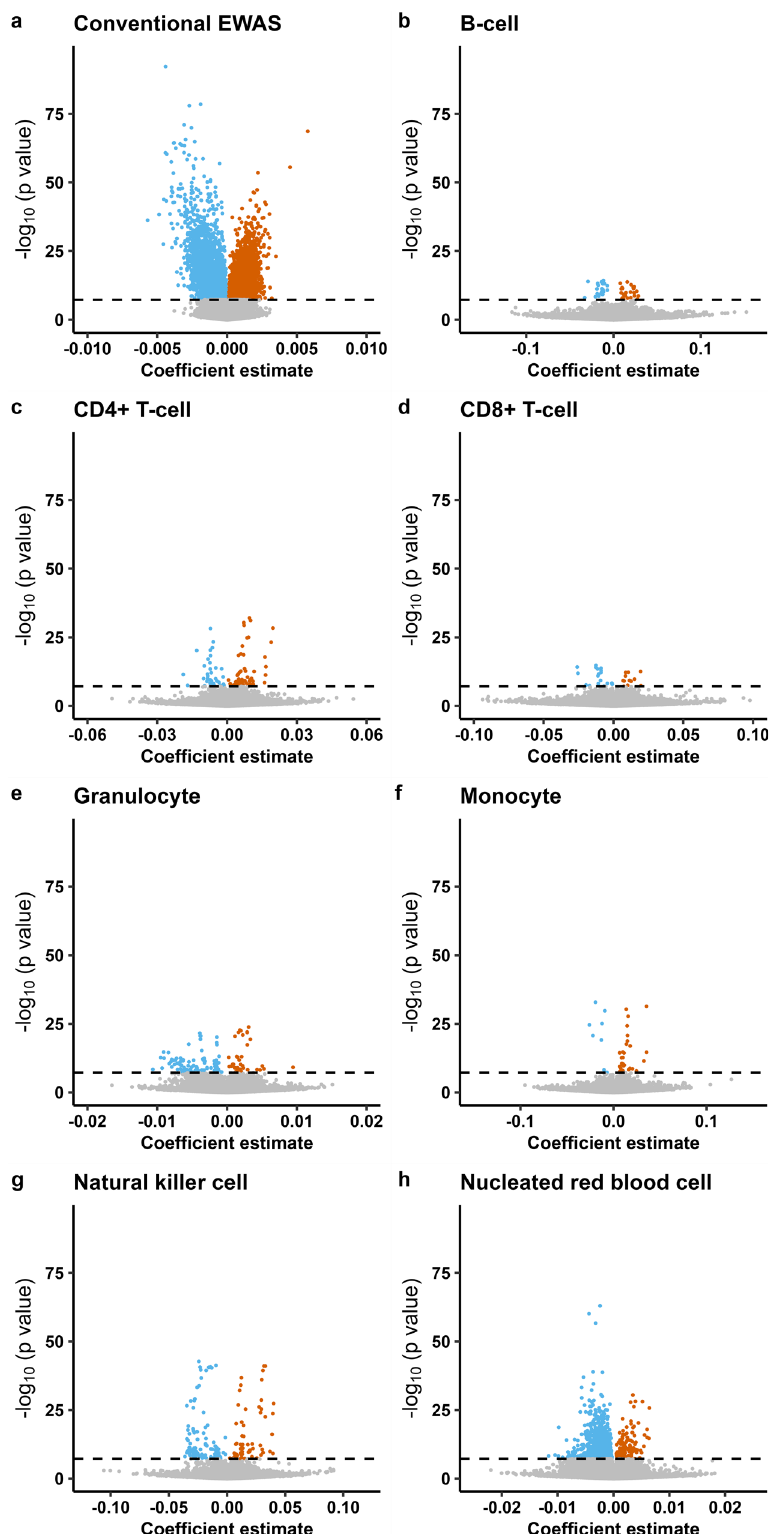
Fig. 3 Volcano plots of the epigenome-wide DNAm associated with GA in START ( n = 953). a Results from the conventional EWAS in which we adjusted for estimated cell-type proportions (see Methods for details of the statistical model). b – h Results for each of the seven cell types from the cell- type speci fi c analysis using CellDMC. Gray dots indicate nonsigni fi cant associations and colored dots indicate those that are Bonferroni-signi fi cant ( p B < 0.05). Blue-colored dots show CpGs with a negative effect size and orange dots show CpGs with a positive effect size. The x-axis represents coef fi cient estimates ( β -values) for the DNAm – GA association, and the y-axis the corresponding -log 10 p values. The horizontal dashed line denotes the Bonferroni-corrected genome-wide signi fi cance threshold ( p B < 0.05).